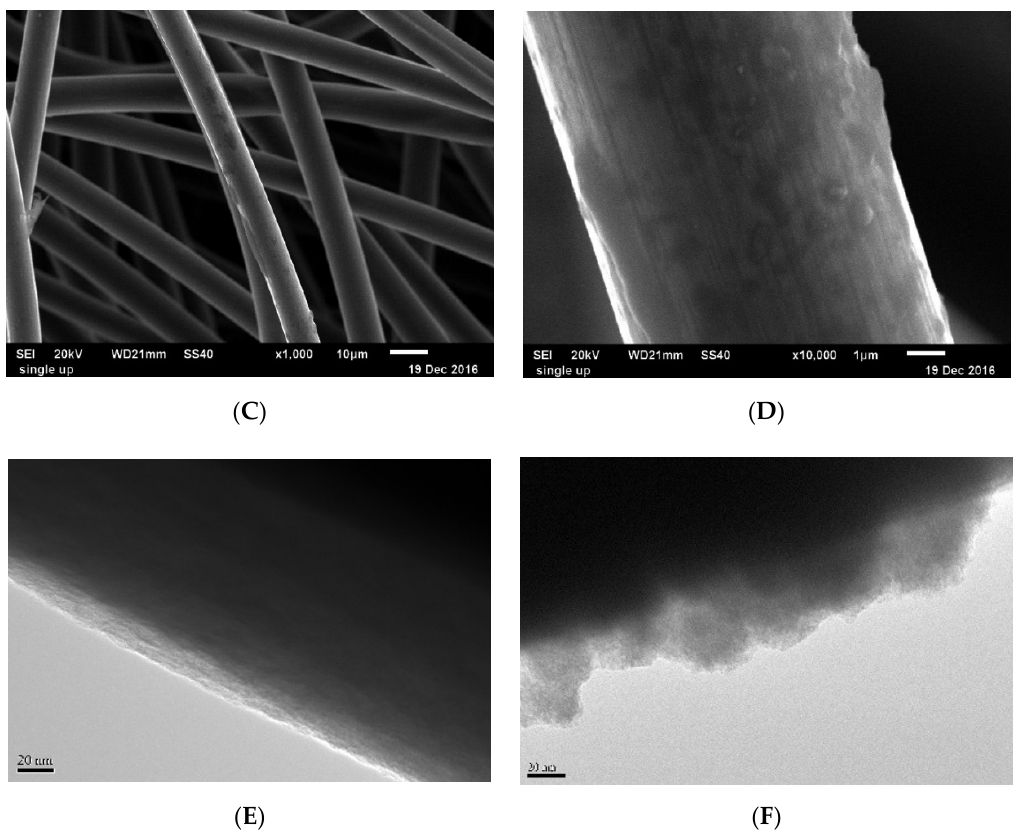
Figure 4. The SEM images of the pristine felt in ( A ) 1000 times zoom and ( B ) 10,000 times zoom; the atmospheric plasma treated felt in ( C ) 1000 times zoom and ( D ) 10,000 times zoom. The TEM images of ( E ) the pristine felt and ( F ) the atmospheric plasma treated felt.